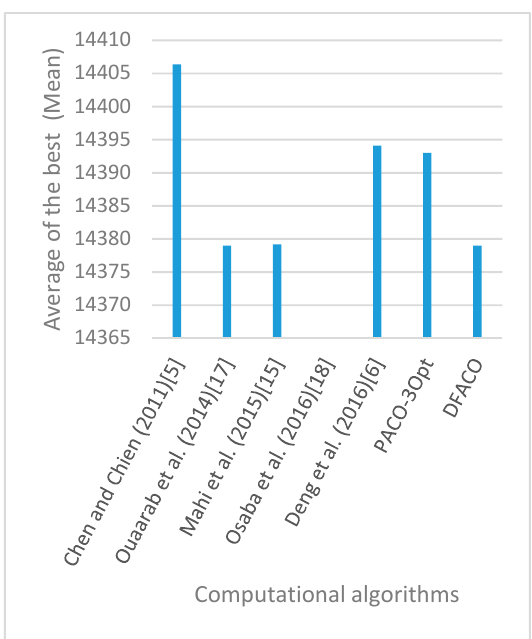
Figure 16. Average of best solutions obtained for instance lin105 by all algorithms.